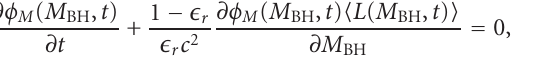
Figure 2: LocalBHMF. The shaded region defines the spread in esti- mates obtained using the M BH - σ ∗ , M BH - L sph , and M BH - M star rela- tionships,as compiled by Shankar et al. [64]. Based on this estimate, the local universe is dominated by SMBHs with M BH < 10 7 M (cid:10)